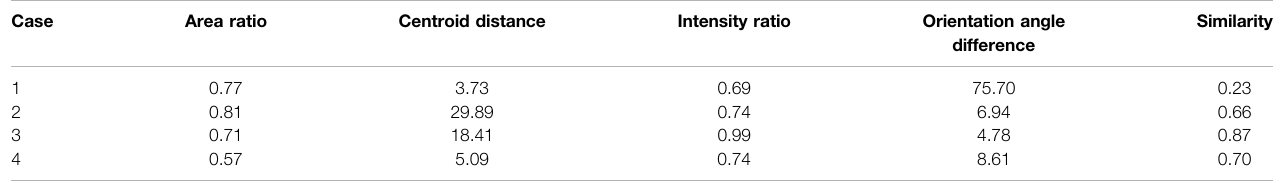
TABLE 3 | Pair attributes of matched objects and the similarity from MODE for the 1 – 3 h lead time precipitation forecasts of four WRWS cases in 2017 over coastal areas of YHR. Case